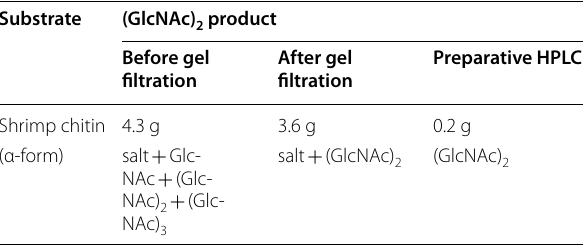
Table 3 A summary of production of (GlcNAc) shrimp